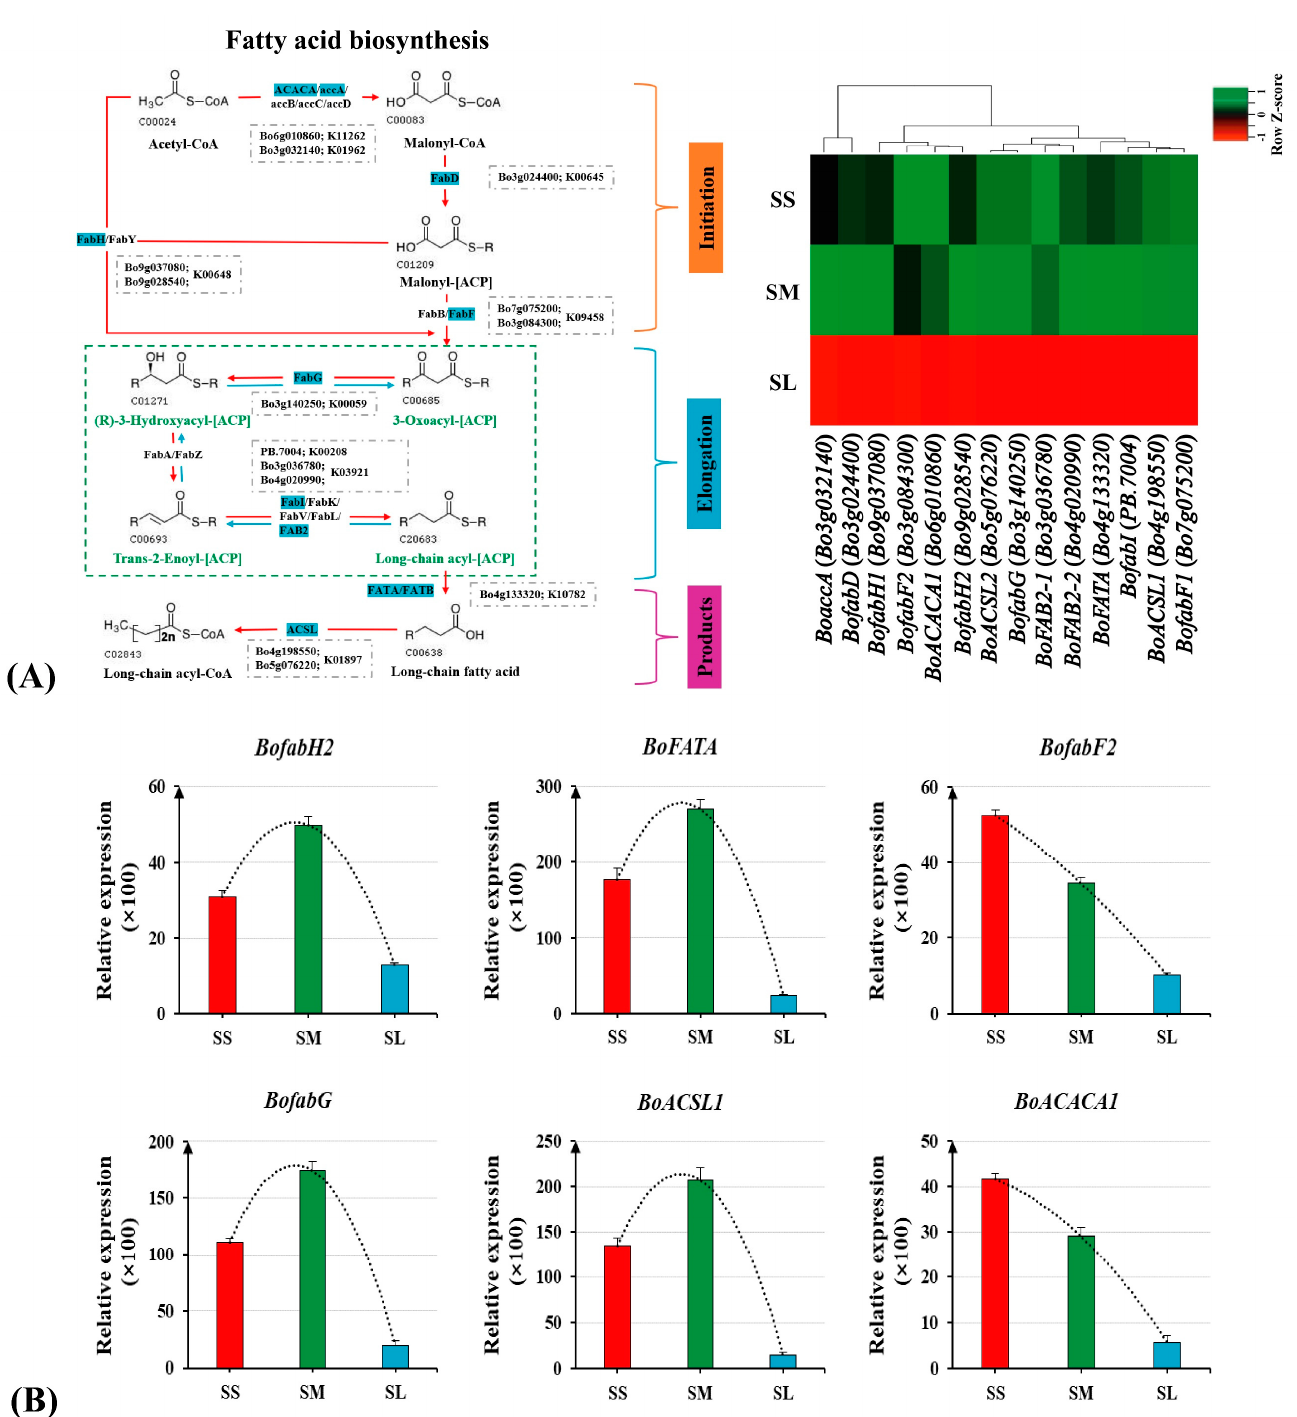
Figure 7. Cluster analysis and qRT − PCR validation of candidate genes related in the fatty acid biosynthesis pathway. ( A ) Fatty acid biosynthesis pathway map and heatmap of candidate gene expression profile. ( B ) qRT − PCR analysis of candidate genes related to the fatty acid biosynthesis pathway.